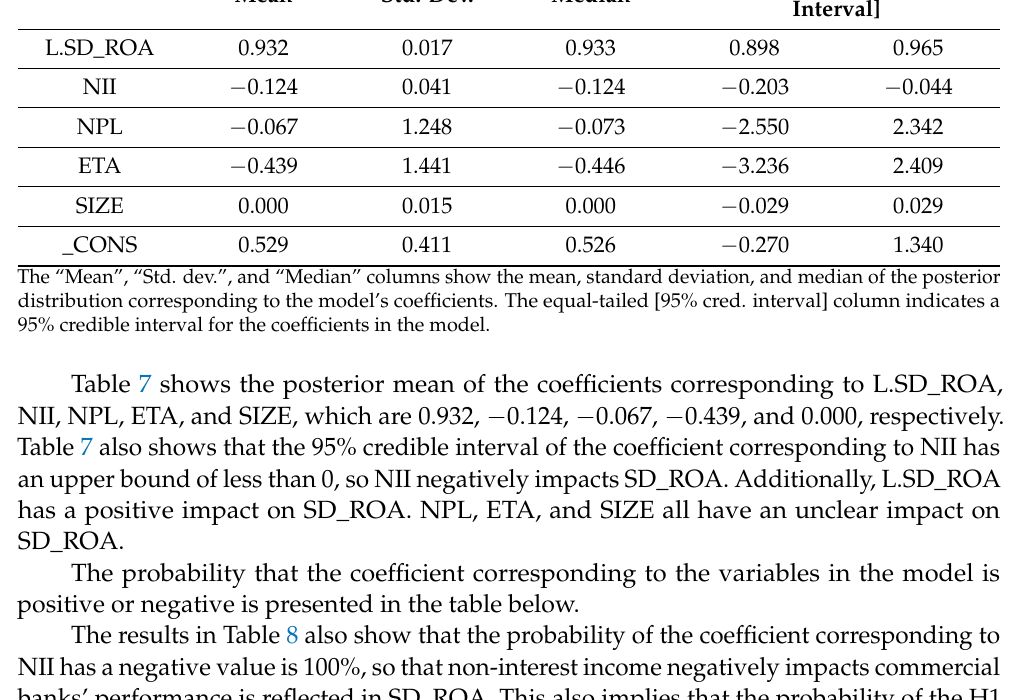
Table 7. Model estimation results using the Bayesian method with dependent variable SD_ROA. Mean Std. Dev.